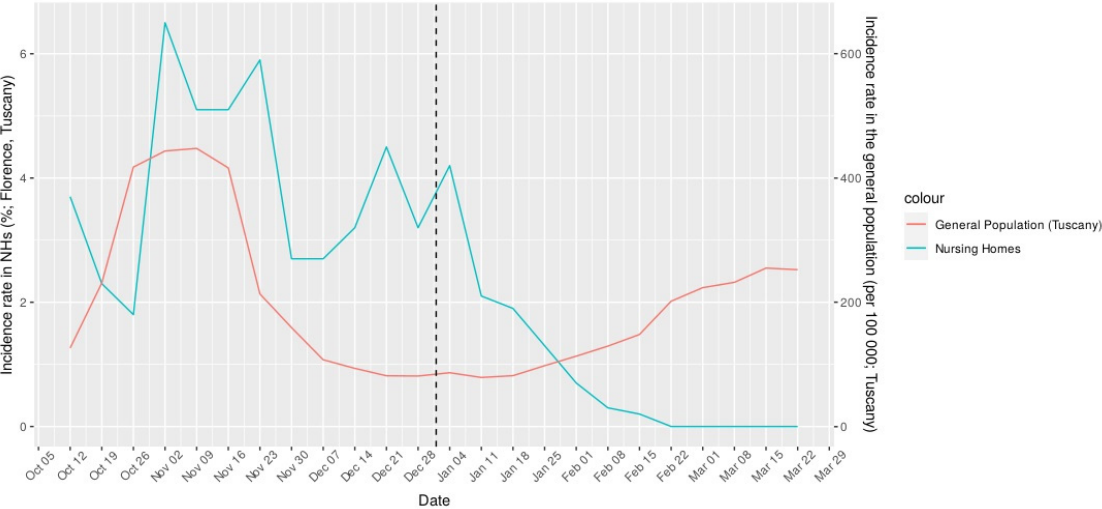
Figure 1. The weekly incidence rate of COVID-19 in NHs of the Florence Health District (per 100 people; blue line) and in the general population of Tuscany (per 100,000 people; red line), before and after the start of the vaccination campaign (dashed vertical line). Data on the general population were obtained from the Italian Ministry of Health. The date on the x -axis indicates the first day of the monitoring week.